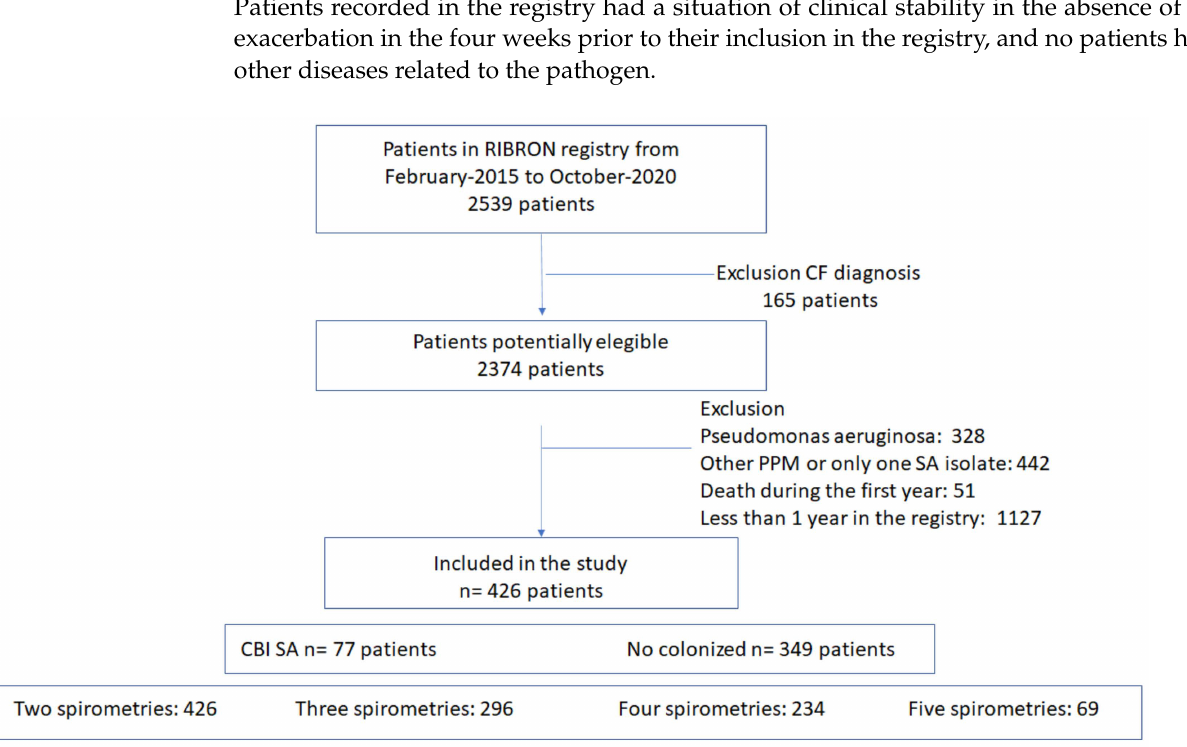
Figure 1. Flow chart of the patients included in the study. CF: cystic fibrosis; PPM: Potentially pathogenic microorganisms; CBI: chronic bronchial infection; SA: Staphylococcus aureus